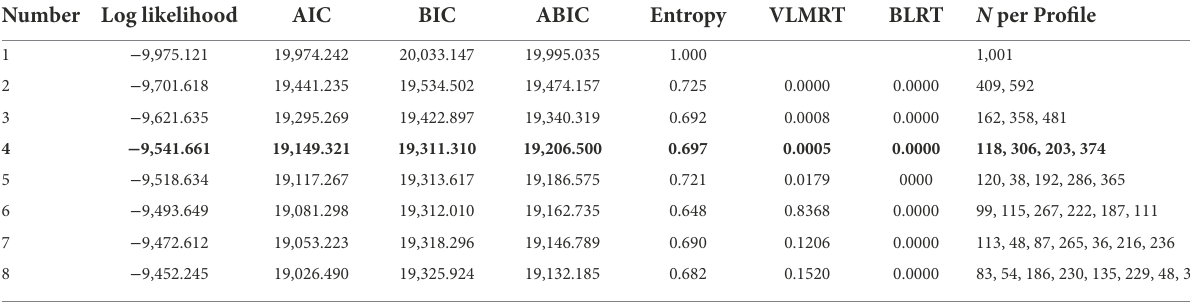
TABLE 3 Comparisons of models for latent profile analysis of environment coping (N = 1,001 couples). Number Log likelihood AIC BIC ABIC